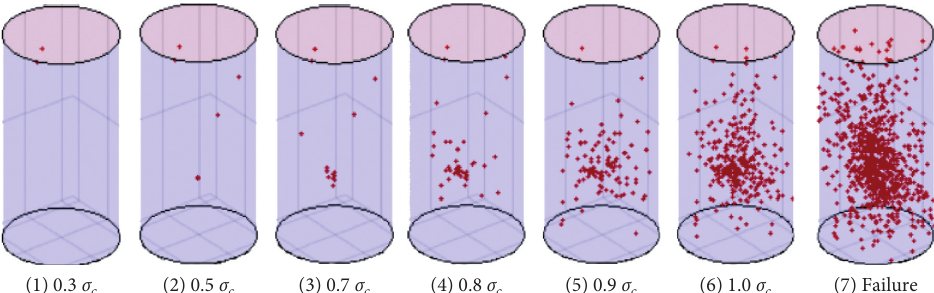
Figure 19: Spatial distribution of AE events at different stress levels for saturated phyllite ( σ